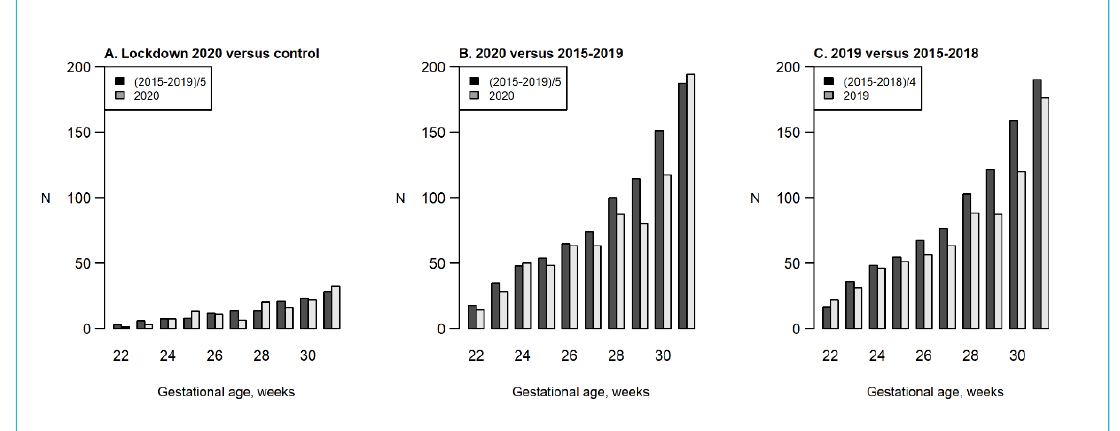
Figure 1: Number of births per gestational age between 22 and 31 weeks gestation in Switzerland.